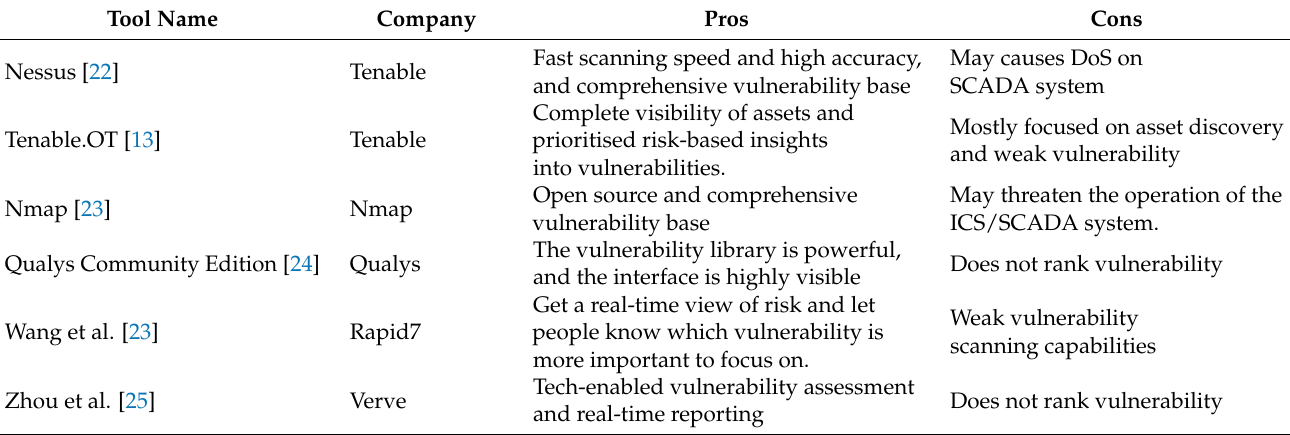
Table 2. Existing Tools for Vulnerability Scanners in